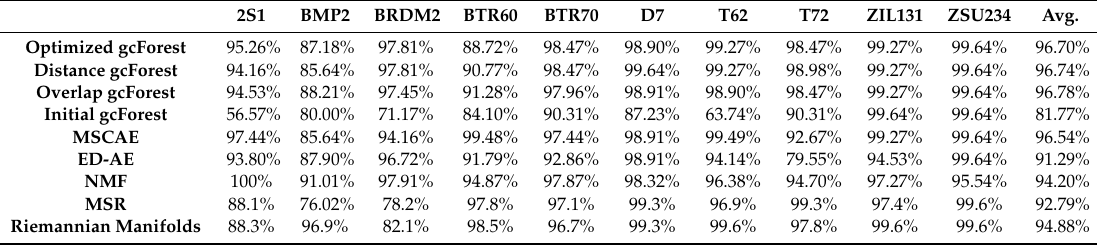
Table 4. Detailed comparison of the classification performance under di ff erent